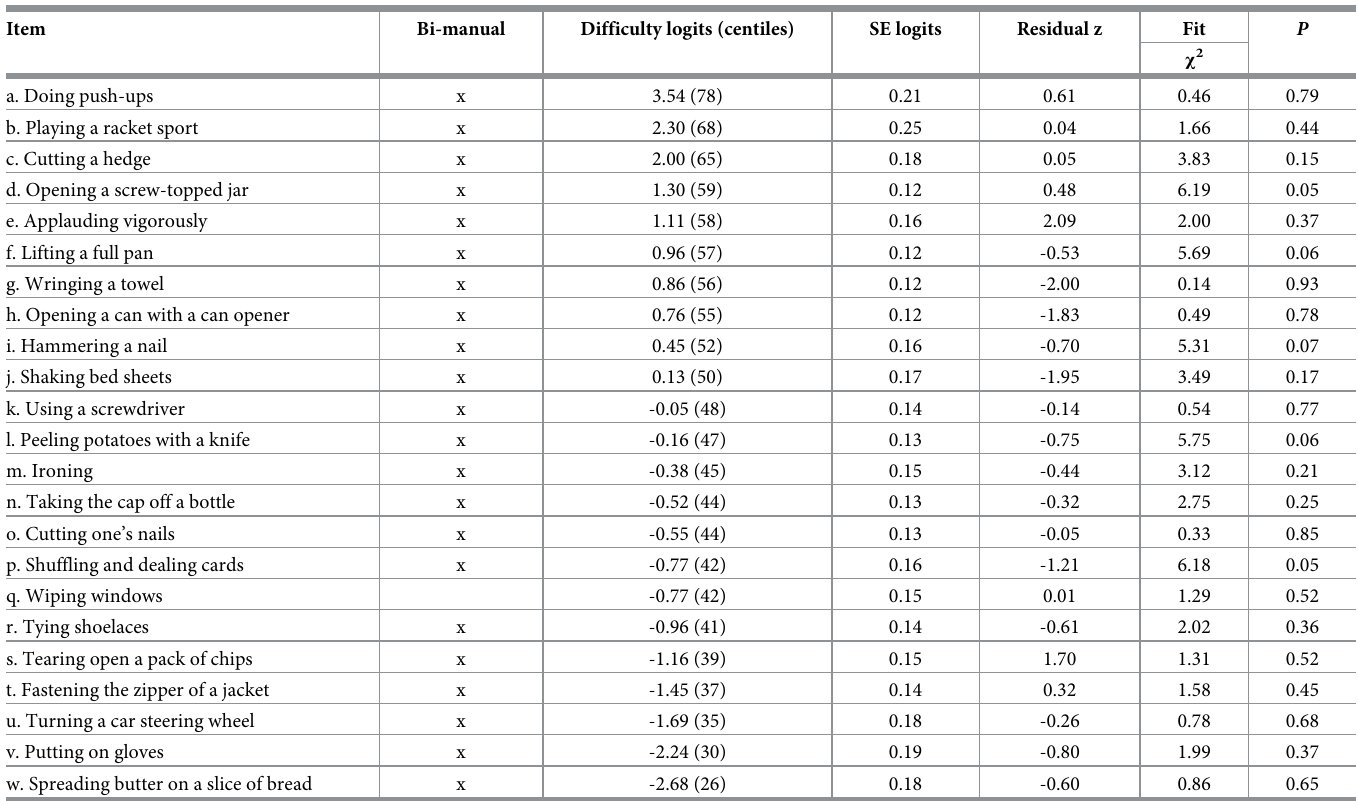
Table 2. Calibration of the 23 items of the ABILHAND-HS.